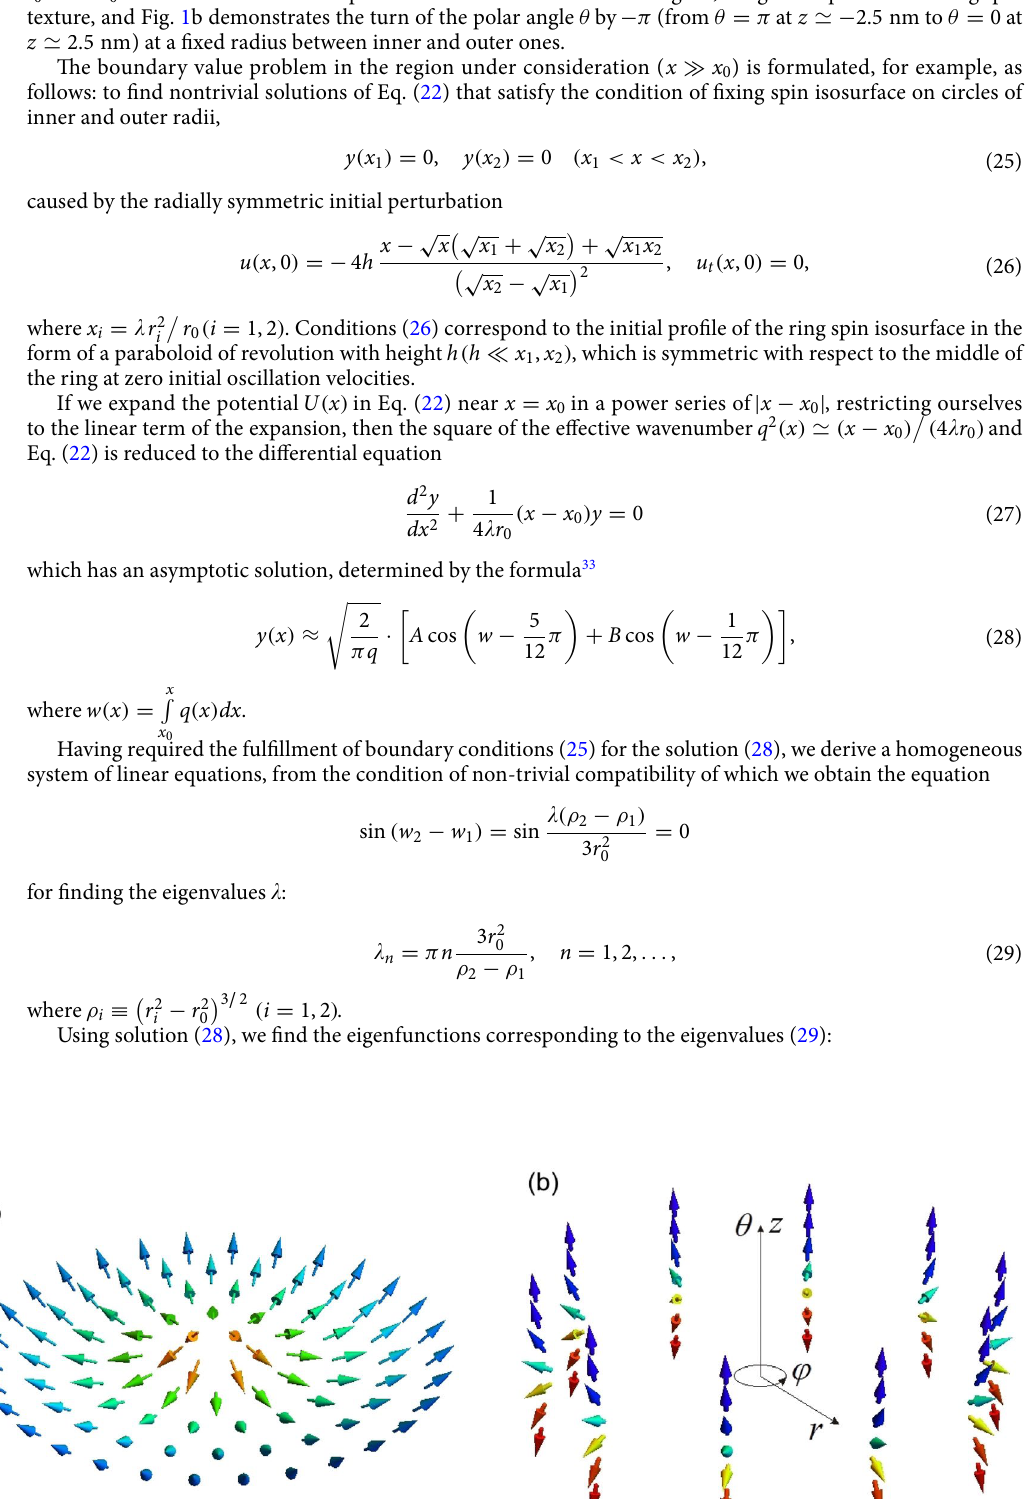
Figure 1. Ring spin configuration (12) at the initial time t 50 ℓ 0 and the thickness of the spin texture d r 0 parameter ˜ = configuration and turn of the polar angle θ by fixed radius between inner and outer